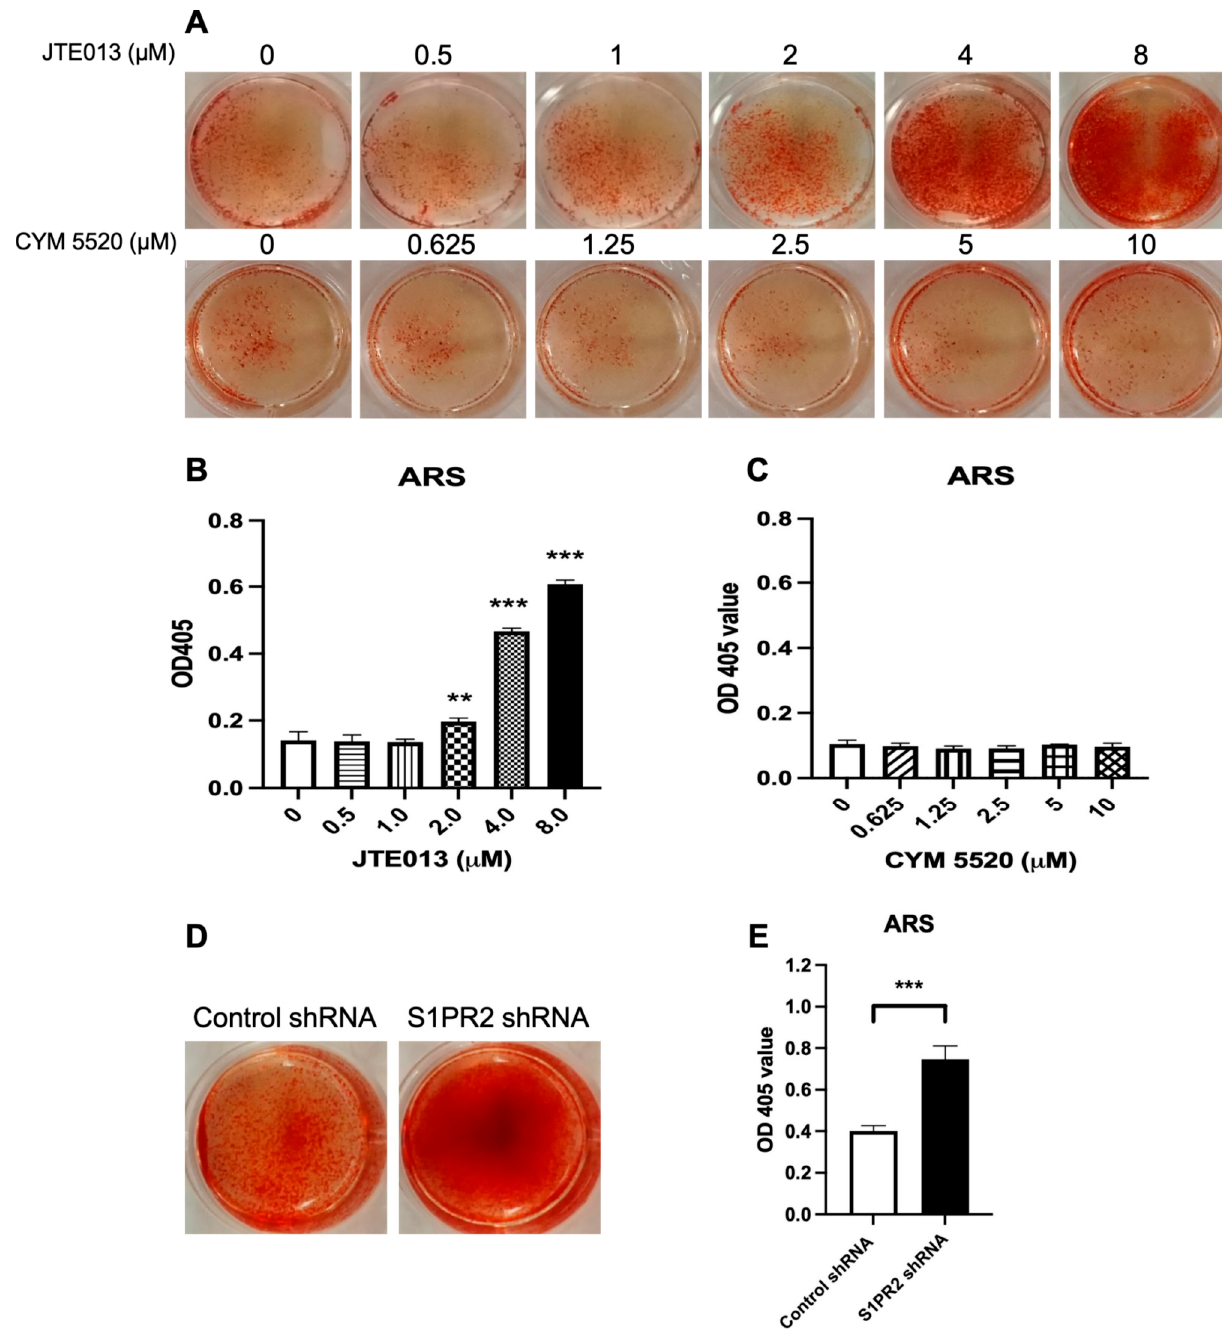
Figure 3. Effects of a S1PR2 antagonist (JTE013), a S1PR2 agonist (CYM 5520), a control shRNA, or a S1PR2 shRNA on alizarin red s (ARS) staining in murine BMSCs. Murine BMSCs were cultured in osteogenic media with either vehicle (DMSO), JTE013 (0.5 to 8 μ M), or CYM5520 (0.625 to 10 μ M) for 21 days, or cultured with a control shRNA or a S1PR2 shRNA for 14 days. ( A ) Representative images of ARS staining in murine BMSCs treated with DMSO, JTE013, or CYM5520. ( B ) Quantification of ARS staining in murine BMSCs treated with DMSO or JTE013 (n = 3, ** p < 0.01, *** p < 0.001). ( C ) Quantification of ARS staining in murine BMSCs treated with DMSO or CYM 5520. ( D ) Representative images of ARS staining in murine BMSCs treated with a control shRNA or a S1PR2 shRNA. ( E ) Quantification of ARS staining in murine BMSCs treated with a control shRNA or a S1PR2 shRNA (n = 3, *** p < 0.001). For quantification of ARS staining, the OD405 value was calibrated by protein concentration in cell protein lysates.